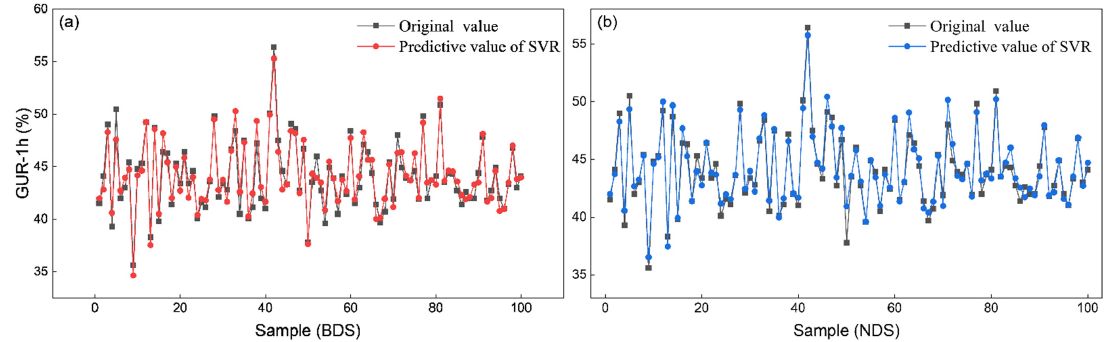
Due to the massive volume of test data, the 100 sets of measured values in the test set of BDS and NDS are marked in black and the correspondingly predicted values are marked in red and blue when the predicted parameter is the GUR-1h. The results are expressed in Figure 6a,b, respectively.